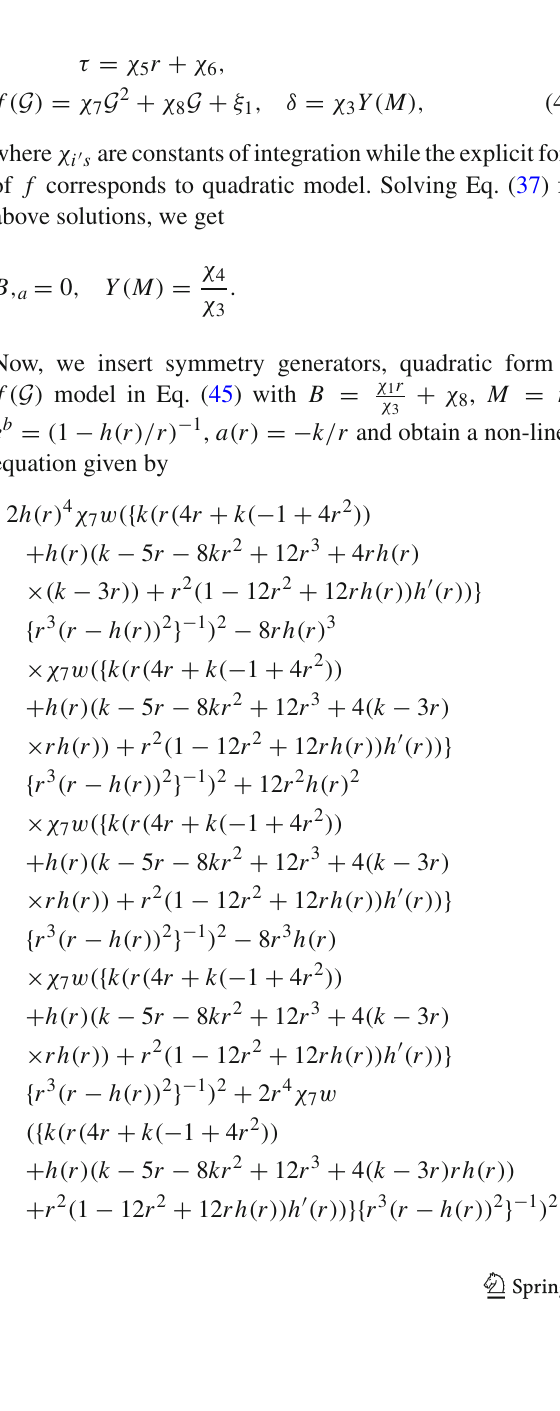
Fig. 4 Evolution of effective NEC versus r for w = −